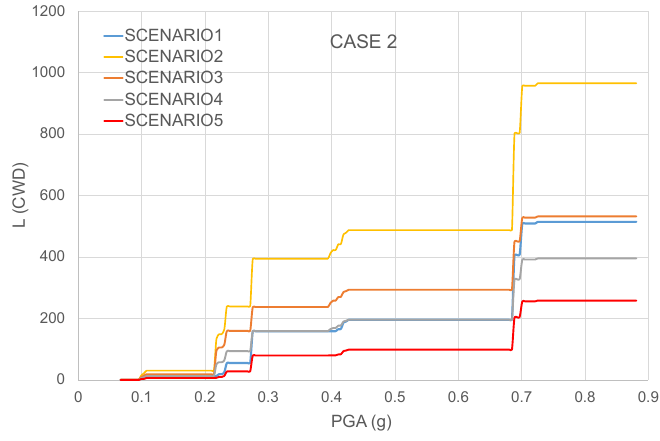
Figure 7. Case 2 ( n 1 = n 2 = 3).